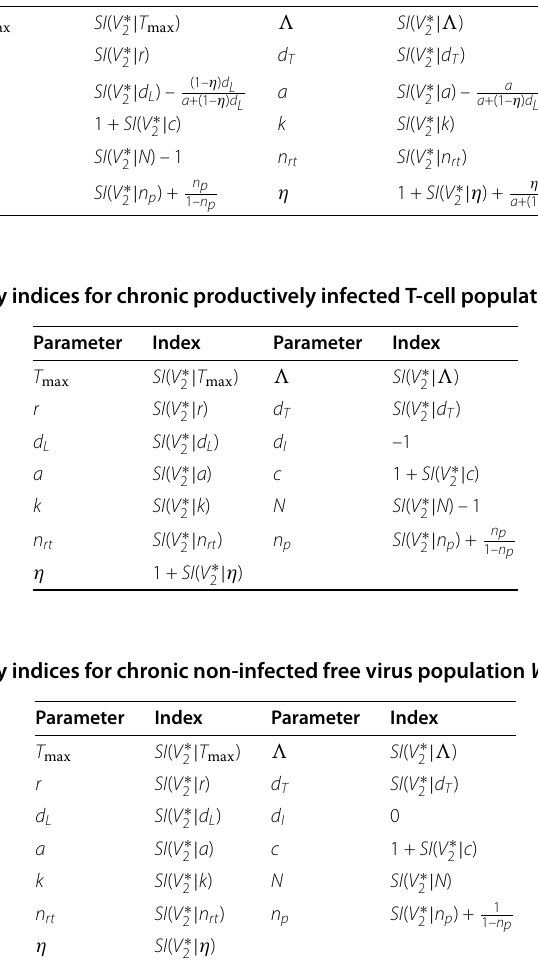
Table 7 Sensitivity indices for chronic latently infected T-cell population L ∗